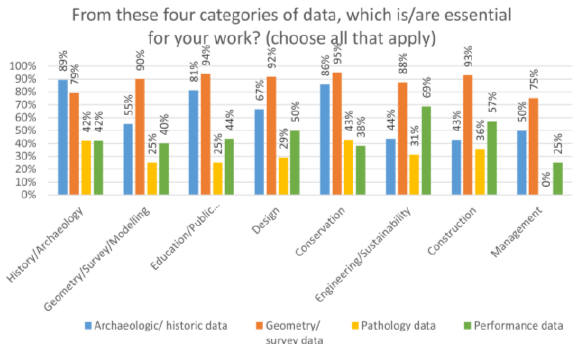
Figure 16: Responses of different interest groups for data categories they consider essential for their work.